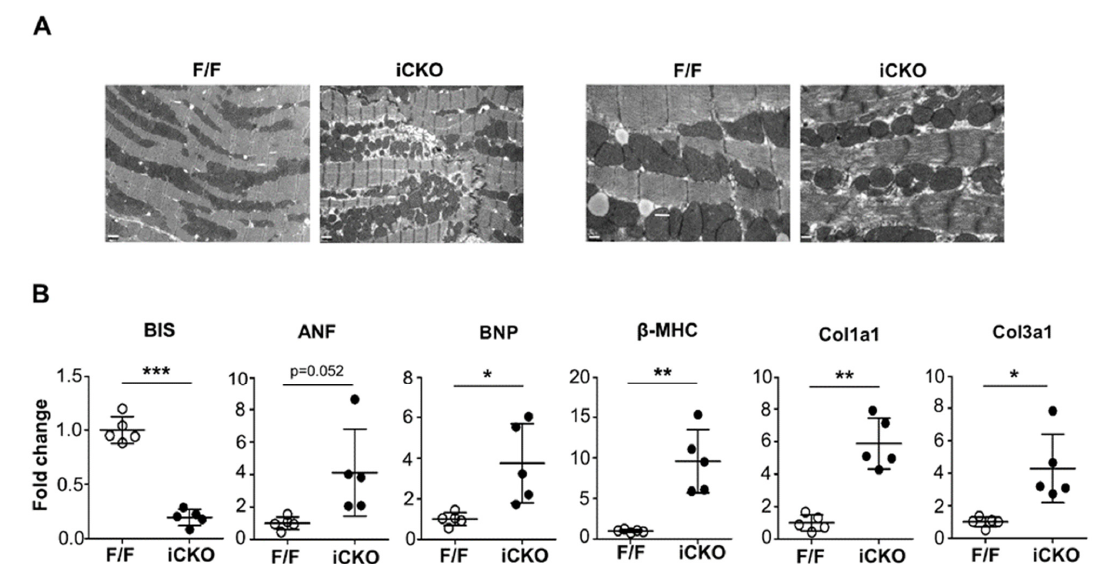
Figure 3. Ultrastructure analysis and expression profiles of cardiac mRNA in Bis -iCKO mice. ( A ) Representative transmission electron microscopy images of the myocardium of F/F and iCKO mice 28 days after tamoxifen injection. Scale bar, 1.0 µ m (left) and 0.5 µ m (right). ( B ) Quantitative analysis of the mRNA levels of cardiac failure markers and profibrotic genes in F/F and iCKO mice 28 days after tamoxifen injection (n = 5 for both groups). Data are presented as the mean ± standard deviation (SD). * p < 0.05, ** p < 0.01, and *** p < 0.001 .